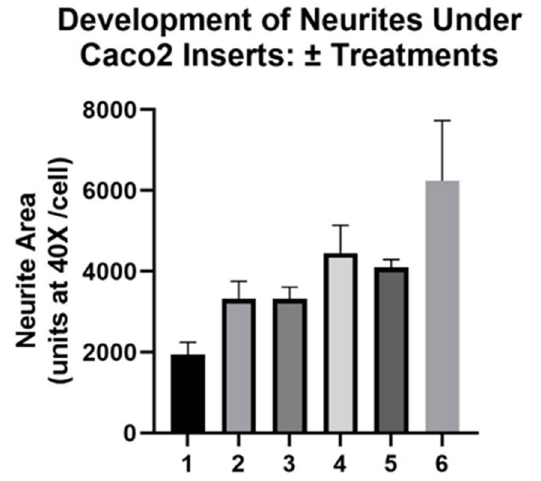
Figure 7. Development of long neurites under Caco2Bbe1 inserts in response to retinoic acid. Caco2BBe1 cells were plated on inserts ( n = 25,000/insert) and grown with regular feeding of complete (10% FBS) media, top and bottom, sufficient to attain high TEER. Eleven days after their plating, SH-SY5Y cells ( n = 400) were plated in a different 24-well plate in complete media without inserts. Fourteen days after Caco2Bbe1 plating, the apical side of the inserts was switched to media with 1% FBS, and most of the SH-SY5Y open wells were replaced with media lacking FBS (0%). On the same day-14, the open wells of SH-SY5Y without FBS received 10 µM retinoic acid (RA). Two days later (day 16), the first two conditions were assessed for neurites: (1) untreated open wells in complete (10% FBS) media, and (2) open wells switched to media lacking FBS but containing RA. Among the remaining wells, some were given a second dose of RA and simultaneously covered with Caco2Bbe1 inserts in apical 1% FBS to be assessed another 2 days later (on day 18). Other wells received a combination second treatment with 10 µM RA + 50 ng/0.5 mL Brain-derived Neurotrophic Factor (BDNF) to be assessed three days later (6 below). Before reaching that stage, the day-18 data were collected from cells given (3) 2 × 2-day basal treatments with RA with the second treatment going under the inserts in 1% FBS, and (4) 2 × 2-day basal treatments with RA with the second going under the inserts reverted to 10% FBS. After this, (5) another day passed and the readings from the inserts in 1% FBS were reassessed (on day 19). (6) Assessments were at last made of the wells that had been treated first open for 2 days with RA alone and then simultaneously with inserts and basal RA+ BDNF for 3 more days after that (until day 19). In each case, the SH-SY5Y cells were washed and stained with crystal violet and photographed using 40× phase contrast microscopy. Cells were traced and average neurite areas were computed using ImageJ software. Bars are means ± SEMs. All experimental bars (2–6) are significantly higher than media-only controls ( p < 0.01). The right five bars were not significantly different from each other.